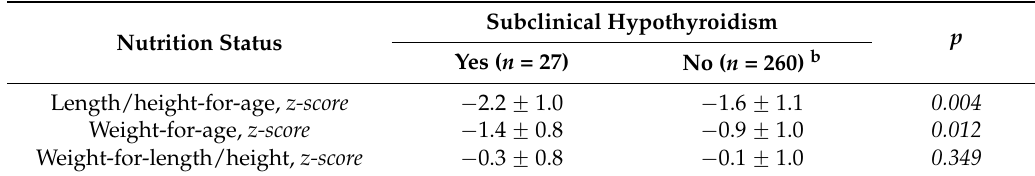
Table 6. Nutrition status among children with subclinical hypothyroidism at follow-up a